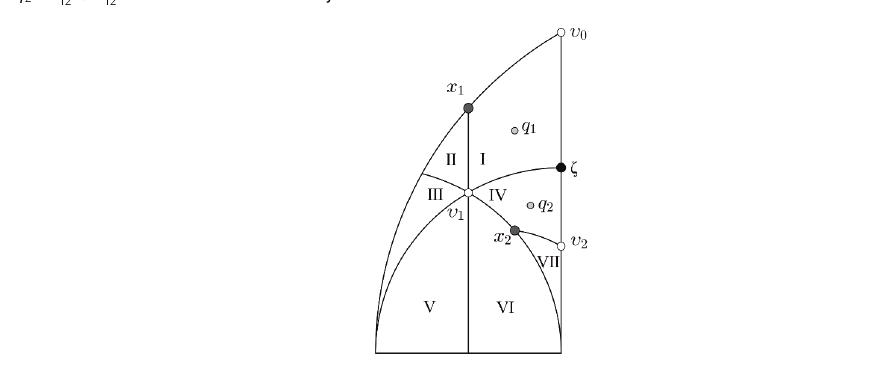
√ i and 23 1 = 3 8 + 8